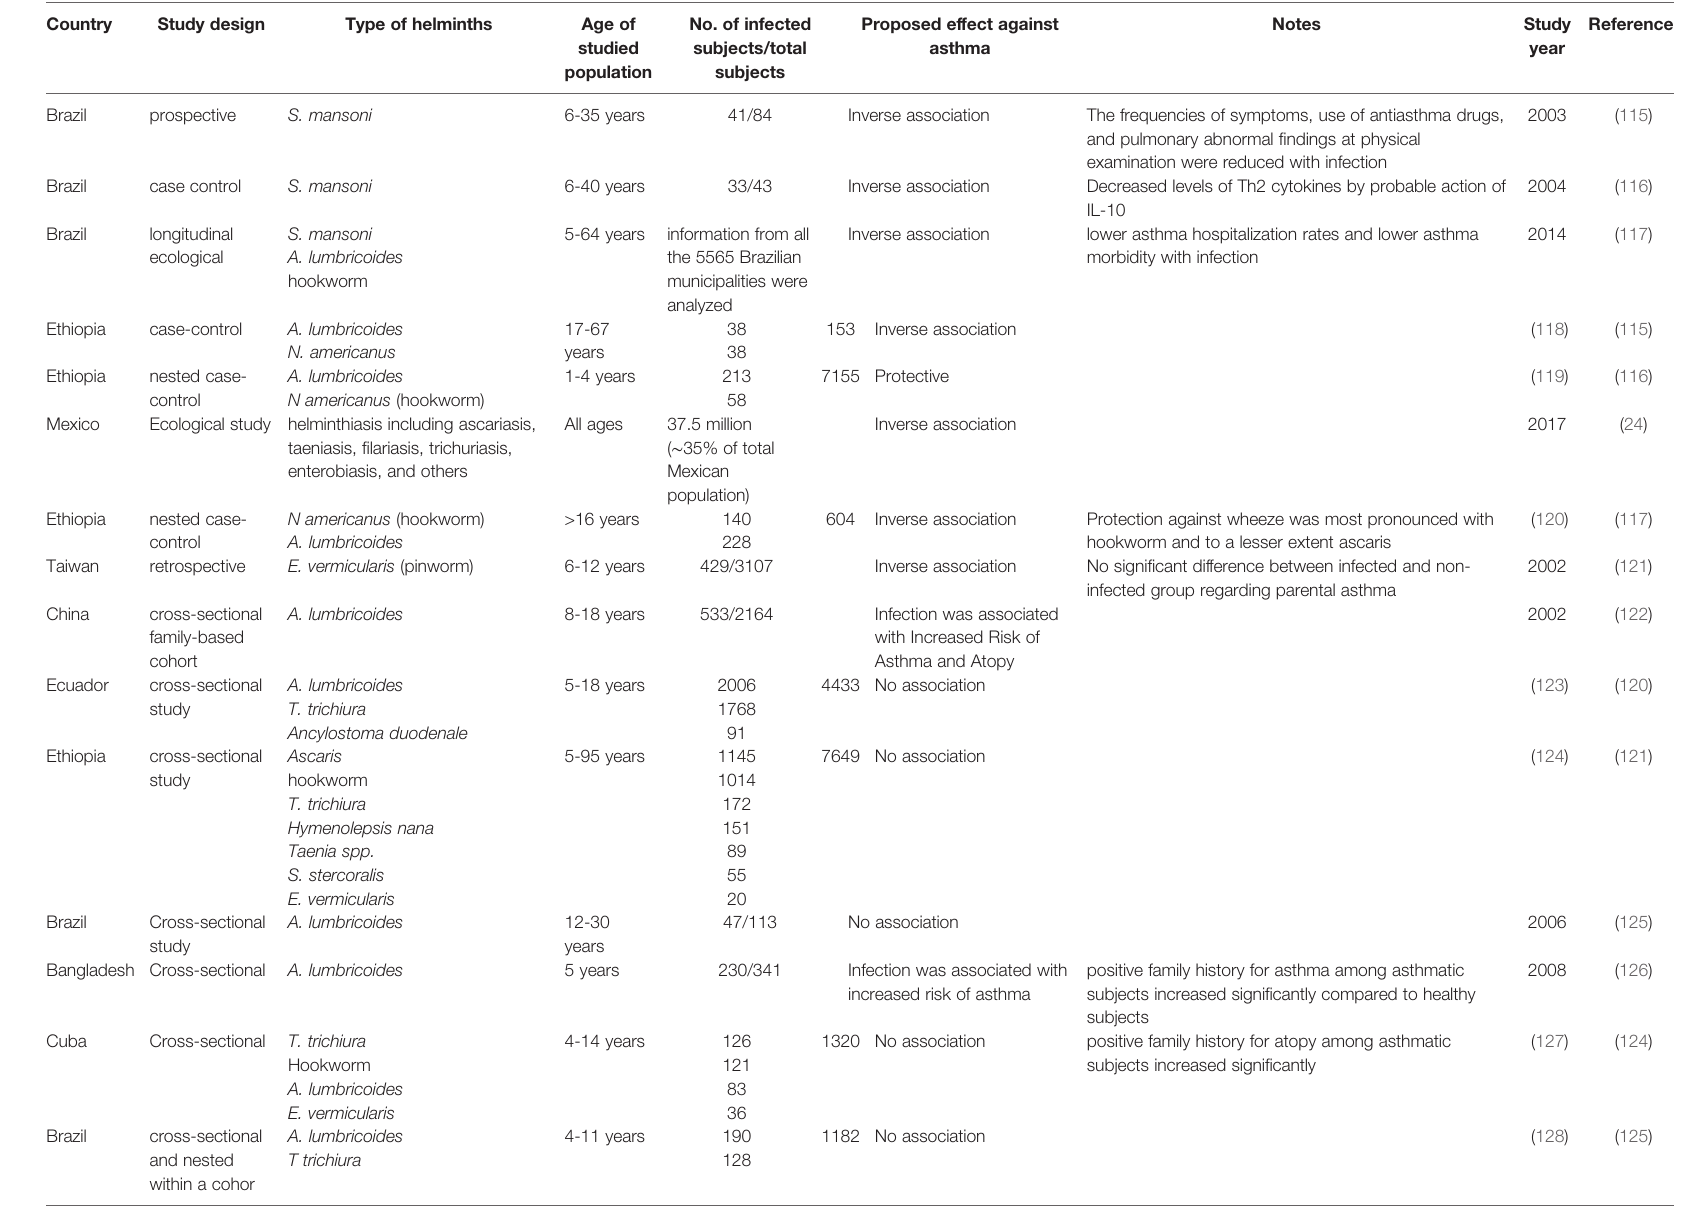
TABLE 4 | Impact of helminth infections on human allergic asthma.